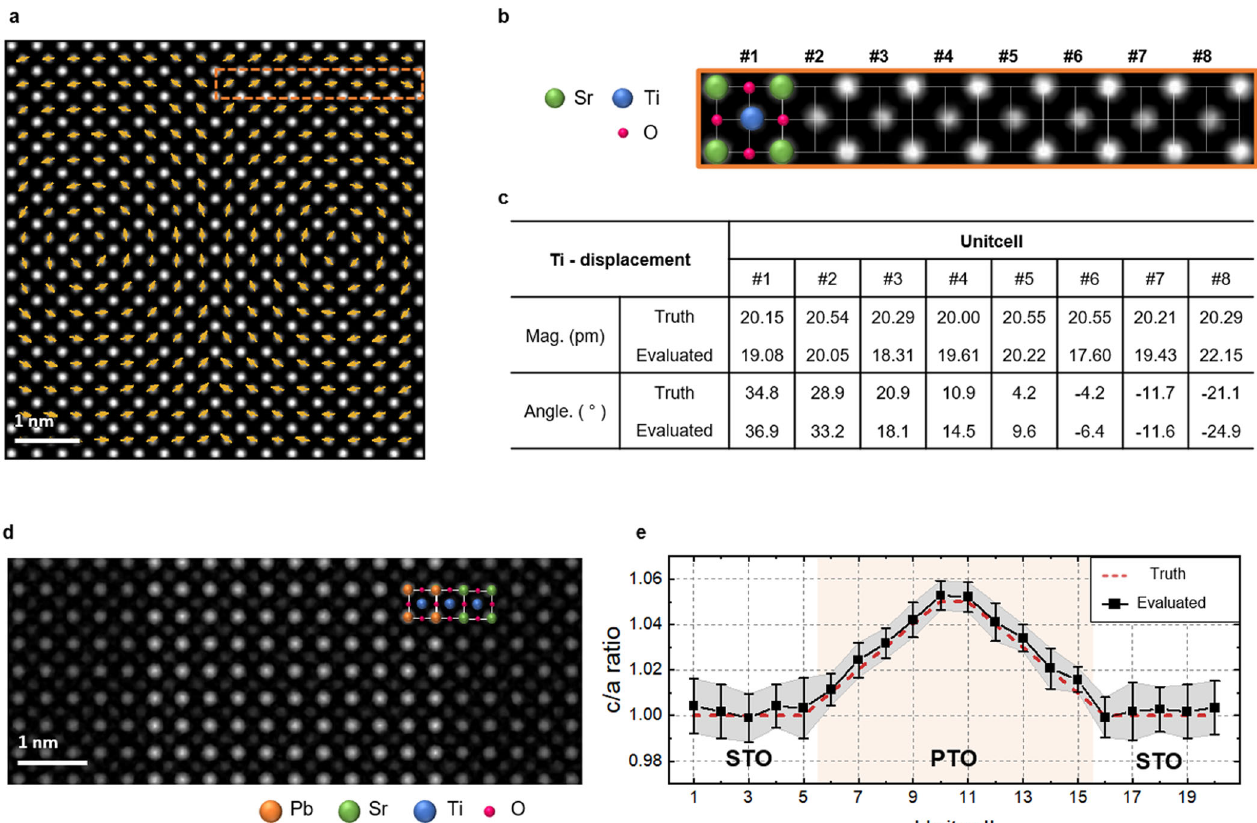
Fig. 6 Examples of structural analysis using atomic peak positions. a Denoised HAADF – STEM simulation image of SrTiO 3 with an arbitrary ferroelectric vortex structure. The vector plot shows Ti off-centering from the neighboring Sr atoms. b Magni fi ed image of the orange-boxed region shown in a . Each Ti atom is displaced from the center of the unit cell. c Detailed evaluation of Ti-displacement in the orange-boxed region shown in a . The truth value is calculated from coordinate information of the simulated structure, and evaluated value is derived